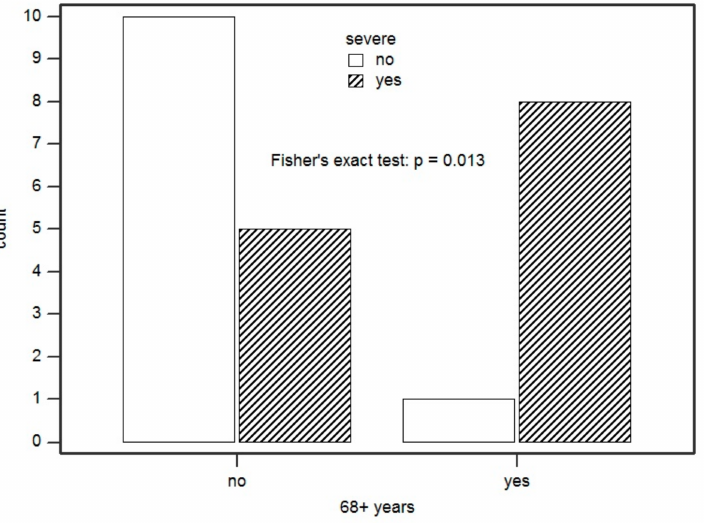
Figure 4. Association between being ≥ 68 years of age and presenting with a severe reaction. Count = number of